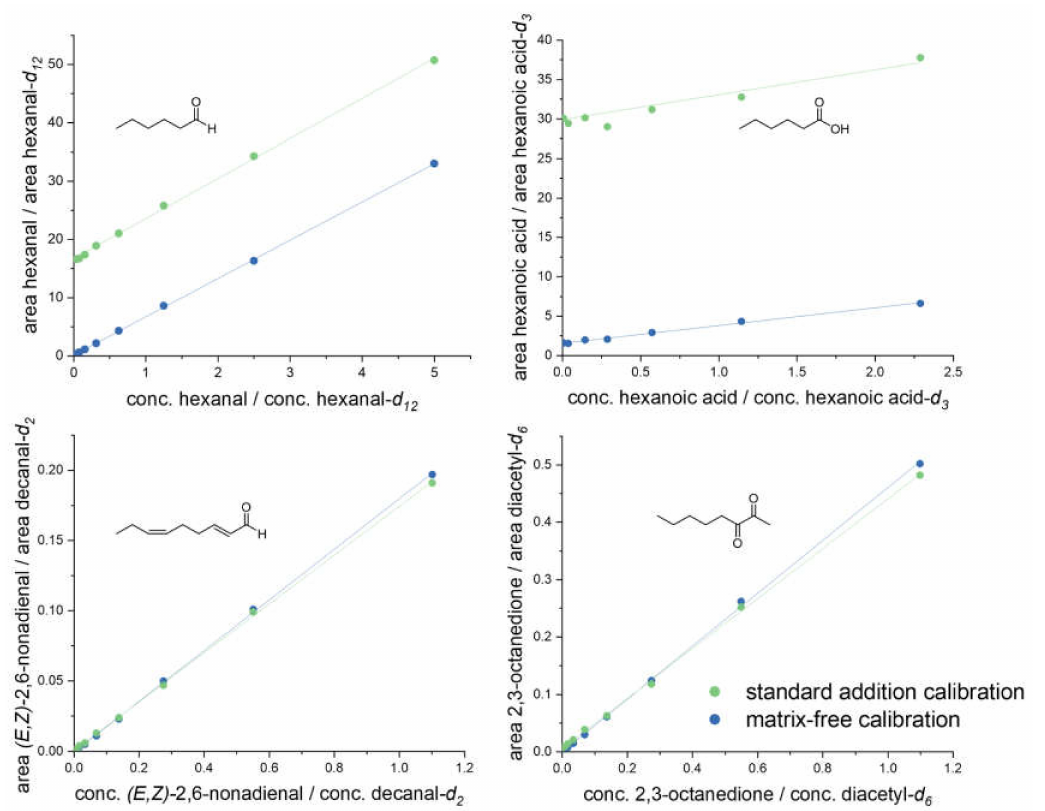
Figure 2. Certain examples (hexanal, hexanoic acid, ( E,Z )-2,6-nonadienal, 2,3-octanedione) of ma- trix calibration curves (standard addition calibration) in a suspended pea protein (C) solution, in comparison to matrix-free calibration in acetonitrile/water (50:50, v / v